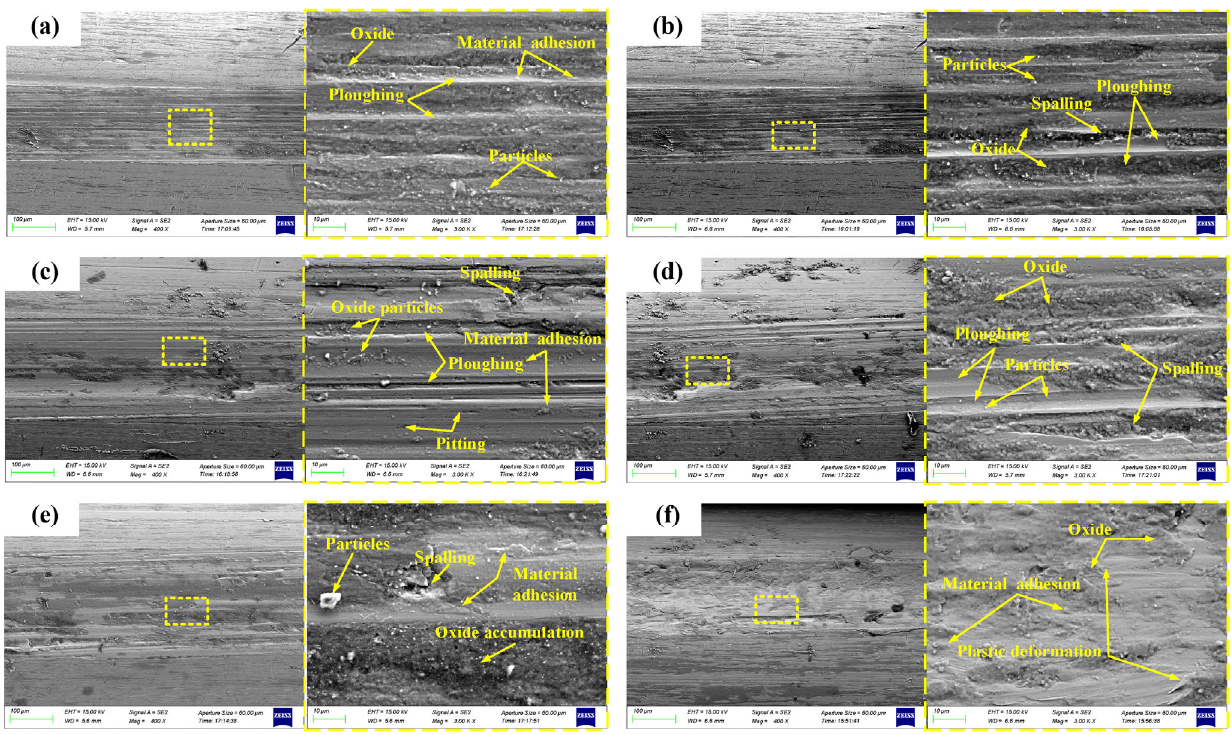
Fig. 22 Wear morphologies of different lateral loads and twist angles under dry friction. (a) 4.2° + 80 N, (b) 4.2° + 160 N, (c) 5.4° + 80 N,